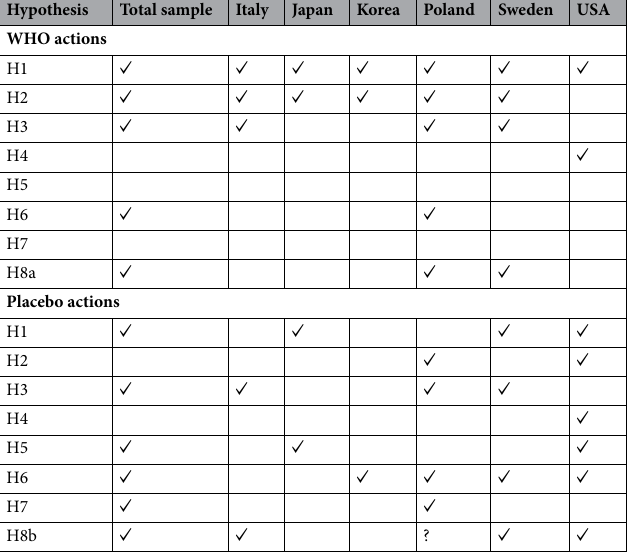
Table 4. Results of hypotheses testing. ✓ —confirmed, ?—correlation was significant but positive (not negative, as